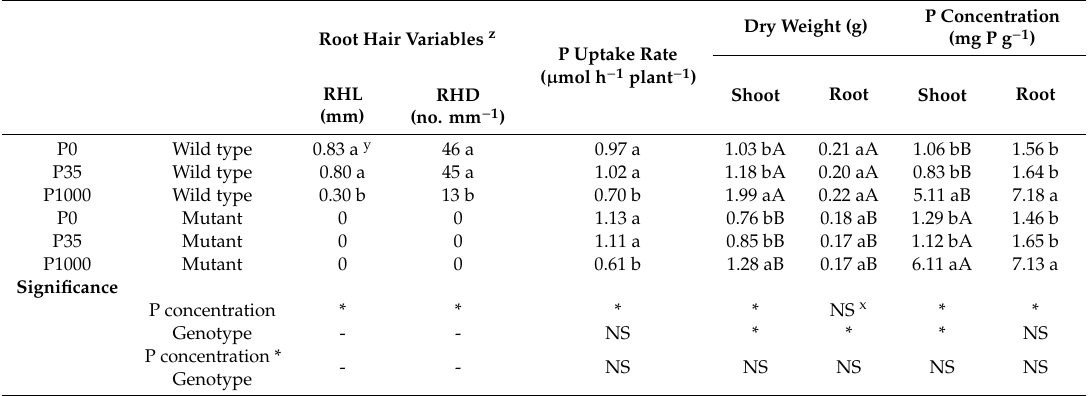
Table 2. Growth response of two barley genotypes at three P levels in a non-split-root system. Root Hair Variables